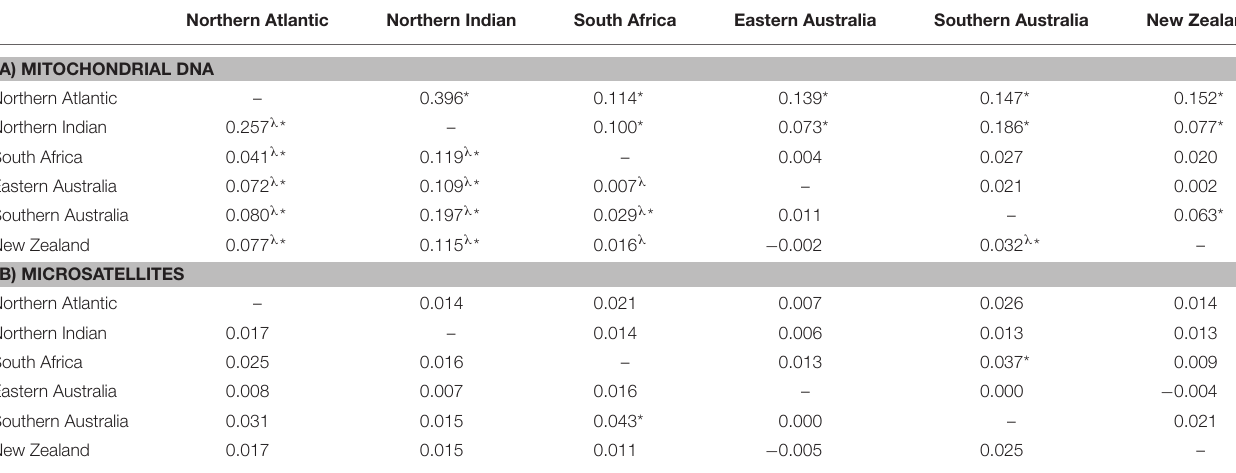
TABLE 2 | Pairwise measures of population differentiation based on (A) mitochondrial DNA and (B) microsatellite data.